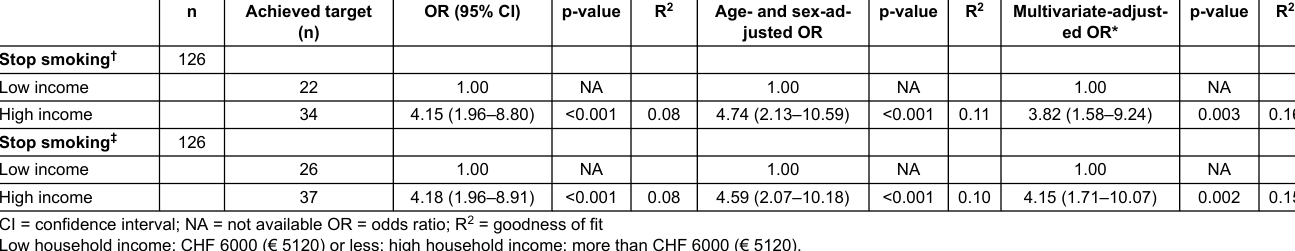
Table S2: One-year smoking cessation and household income, according to different scenarios for missing information.